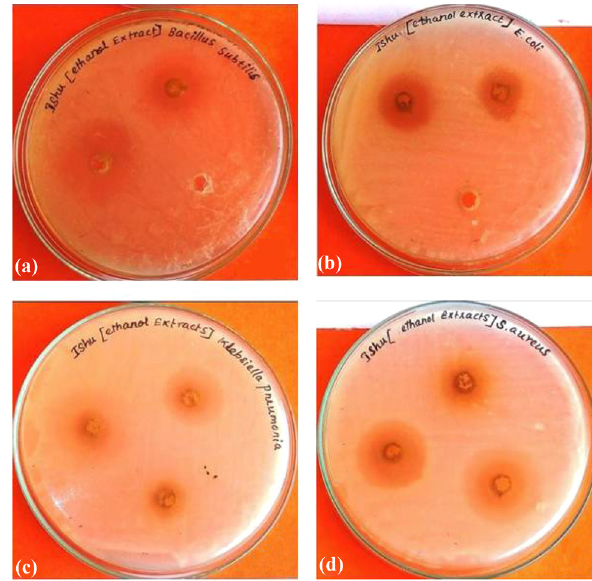
Figure 5: Antimicrobial activity of ethanolic extract of D. viscosa : ( a ) B. subtilis , ( b ) E. coli , ( c ) K. pneumoniae , and ( d ) S. aureus .